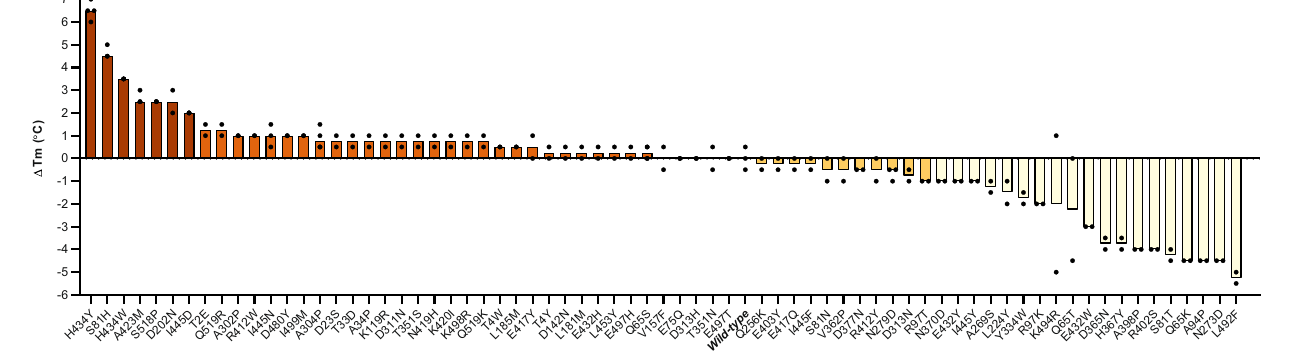
Fig.2|Thedifferencein T m valuesforFRESCO-predictedEUGOmutants. The T m values of 70 single mutants (2 – 4 replicates) determined by using the Thermo fl uor assay are shown with dots and the average T m values are shown in bars. The average T m of wild-type EUGO is 66.5°C and set as a reference. The seven most